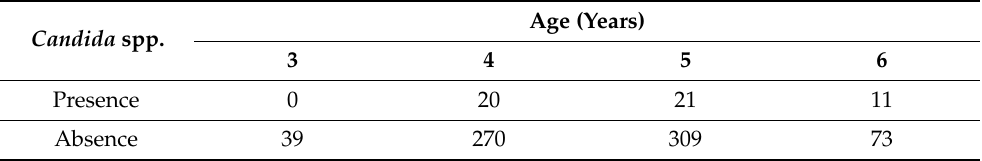
Table 3. Distribution of the colonization by Candida spp. according to age. Candida